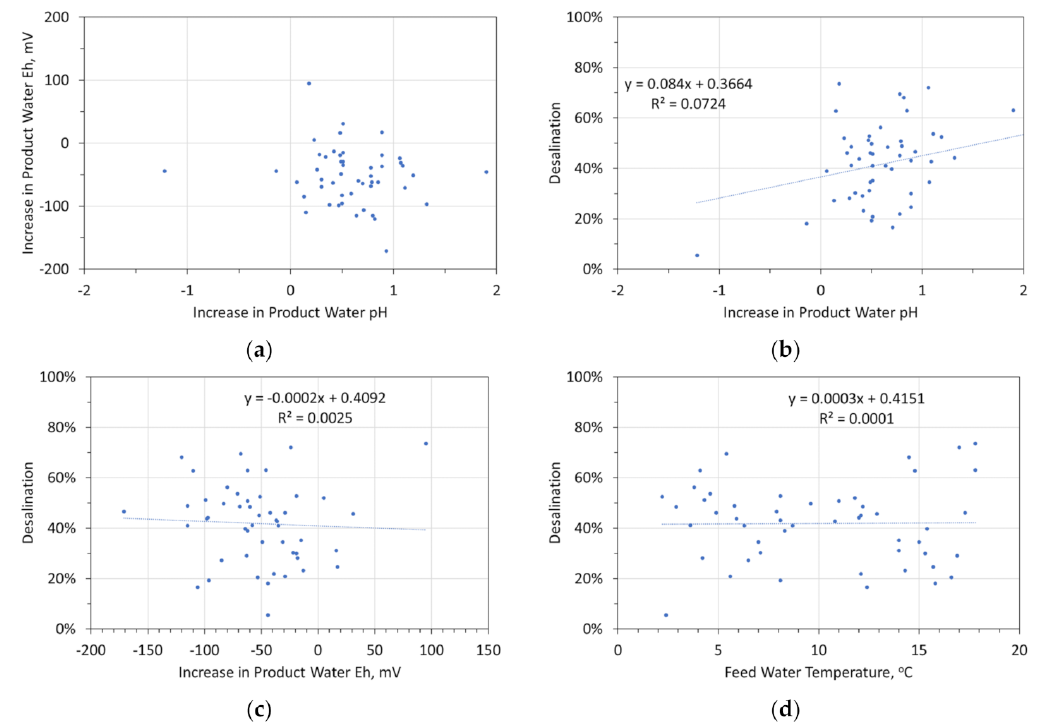
Figure A5. Change in redox parameters and their relationship to desalination. ( a ), increase in Product water pH versus Increase in product water Eh; ( b ), Increase in product water pH versus Desalination; ( c ), Increase in product water Eh versus desalination; ( d ), Temperature versus